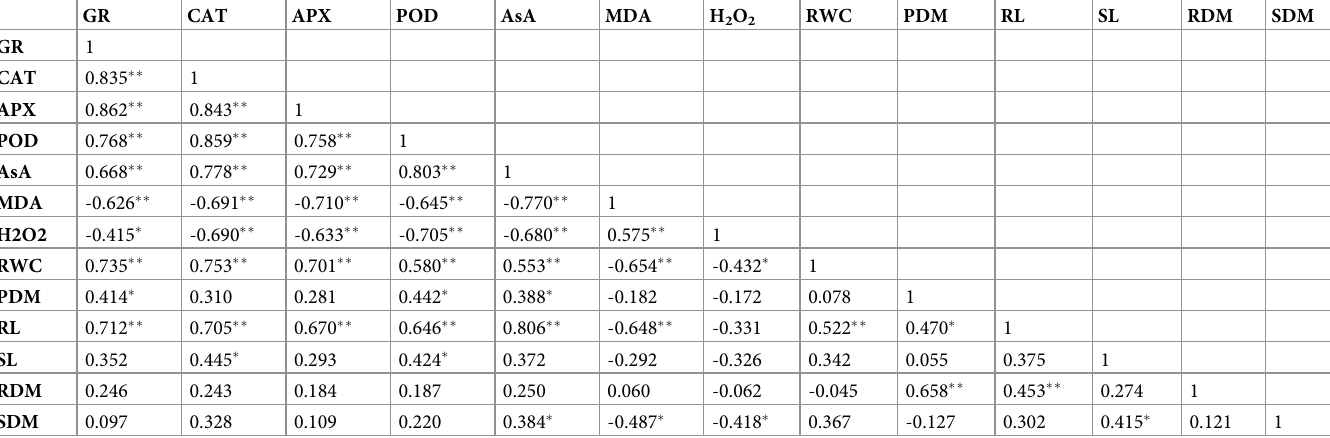
Correlation between key growth and physio-biochemical parameters, average values of eight T lines along with WT were used for correlation analysis. Where: GR-